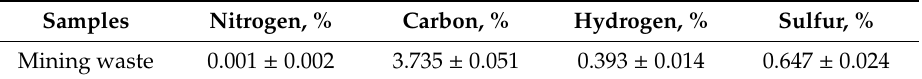
Table 1. Elemental analysis Carbon, Hydrogen, Nitrogen and Sulfur for mining